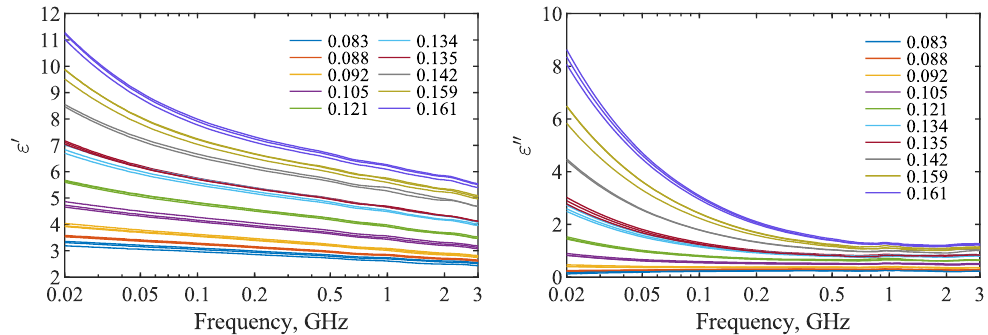
Figure 1. Spectra of the real ( left ) and imaginary ( right ) parts of the complex dielectric permittivity of all measured rapeseed samples of moisture content given in the legend (in g g − 1 ) .